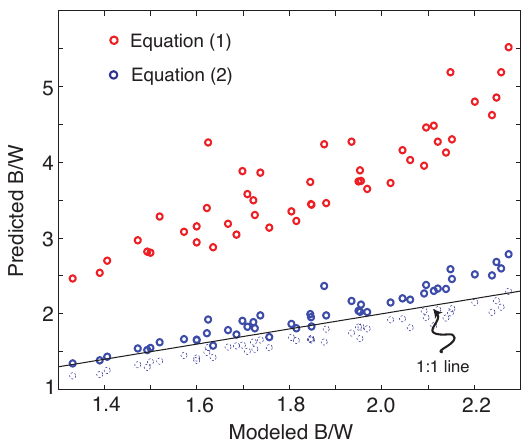
Fig. 6. Modeled ratio of benthic to water-column denitrification ( B/W ) compared to that predicted by a linear isotope mass balance (Equation 1, bold red circles) and an isotope mass balance corrected for the fractional consumption of nitrate in suboxic zones (Equation 2, bold blue circles). The faint dashed blue circles show results from equation (2) when the mean ocean δ 15 NO 3 is corrected for fractionation during uptake of nitrate to form organic matter.